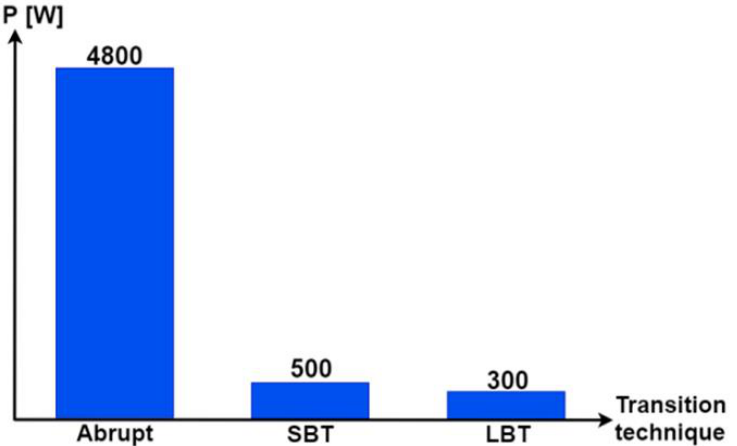
Figure 16. Ripples with different transition techniques.